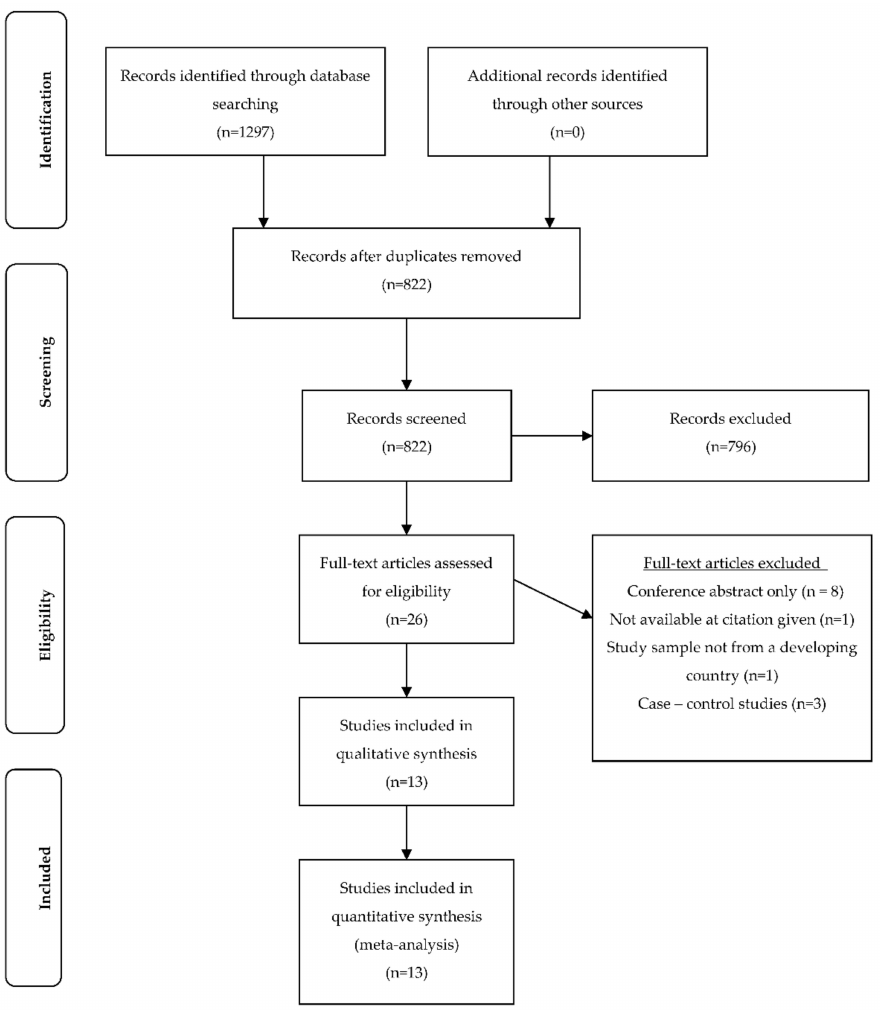
Figure 1. Flow diagram of included